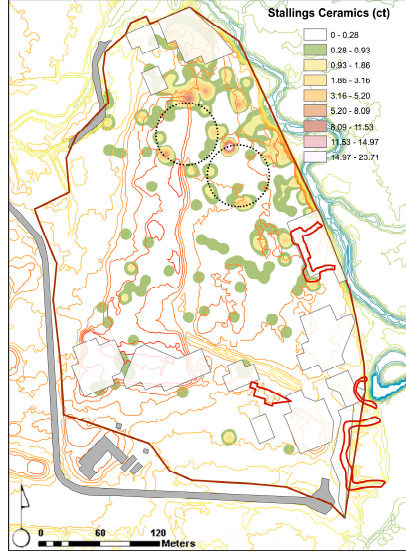
Figure 5. The distribution of Stallings period ceramics recorded through a shovel test survey. Circular patterns discussed in the text are indicated by dashed circles. Areas whited-out were not shovel tested. Contour spacing is 1 m. Contours are based on the LiDAR dataset and use the NAD 1983 and NAV 1988 horizontal and vertical datum, respectively.